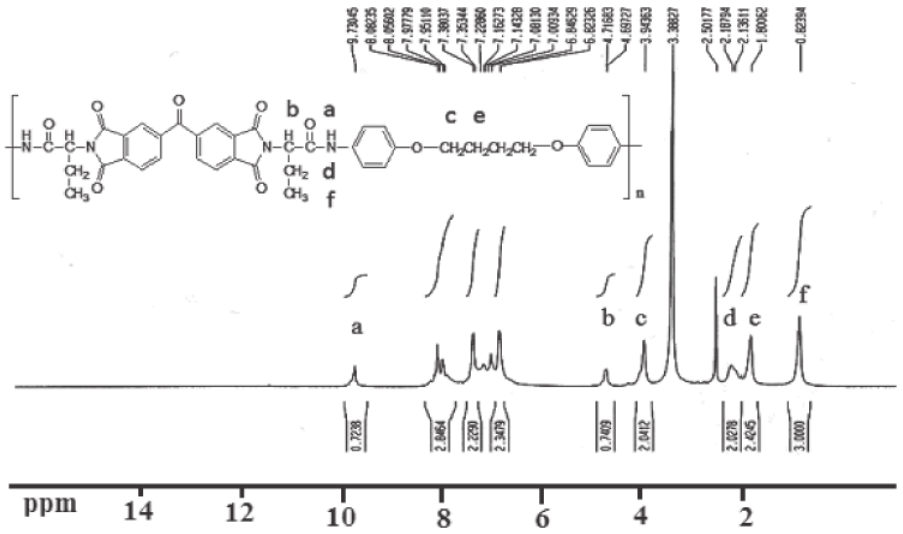
Fig. 5: 1 H-NMR spectrum of PAI 8f